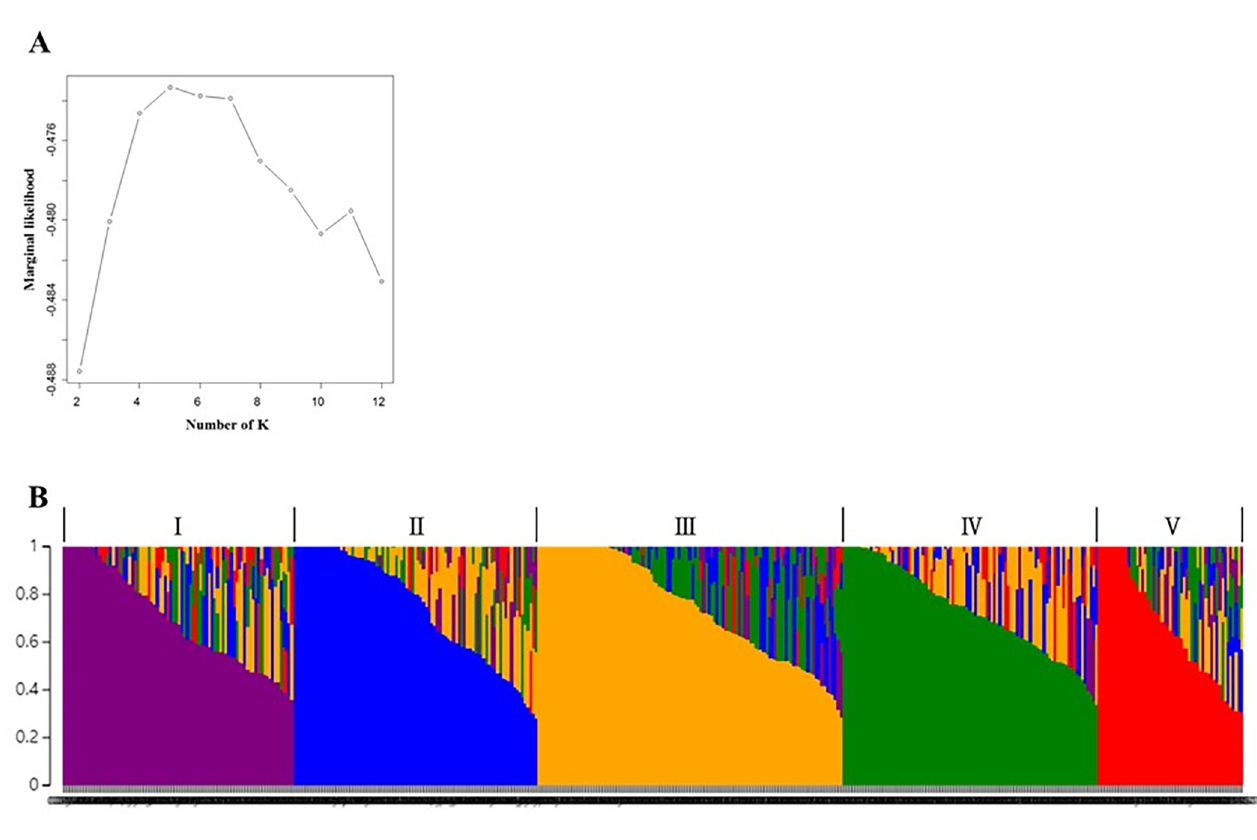
Fig 3. Population structure of the core collection. (A) The number of populations (K = 5) was selected using marginal likelihood provided by fastSTRUCTURE. (B) Five subpopulation clusters inferred by fastSTRUCTURE are indicated by different colors.